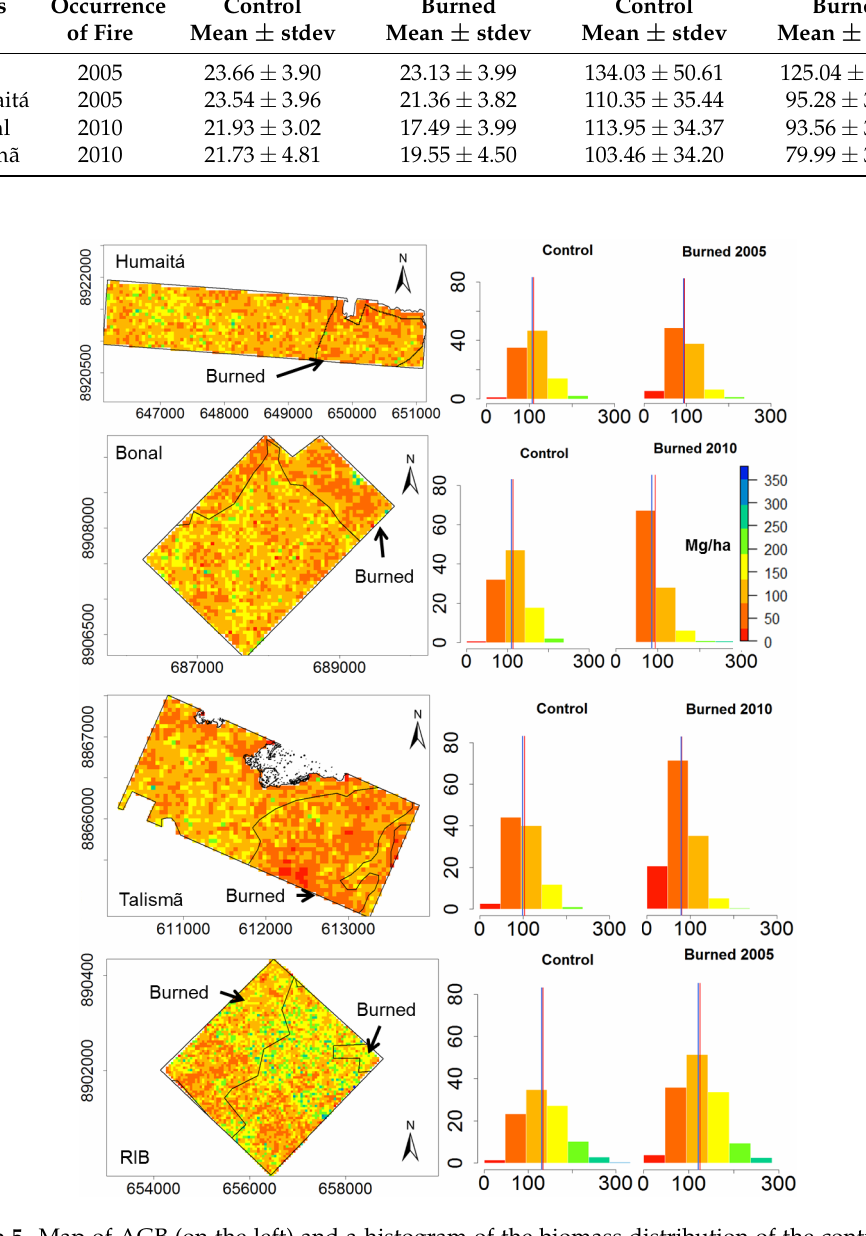
Figure 5. Map of AGB (on the left) and a histogram of the biomass distribution of the control and burned areas (on the right) for Humaitá, Bonal, Talismã and Rio Branco study sites. On the histogram, the red lines are the average biomass and the blue lines are the median